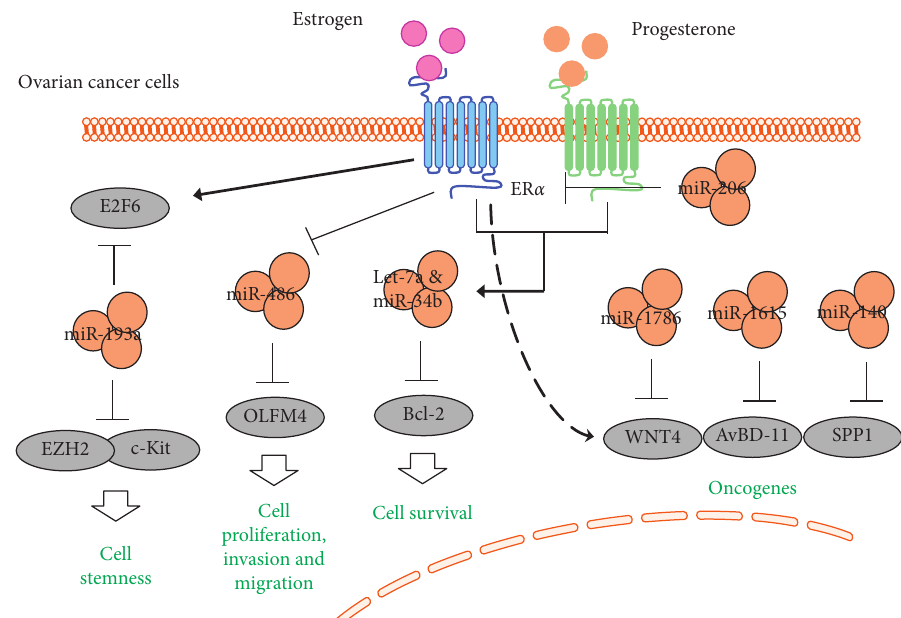
Figure 1: The interaction of miRNAs and estrogen in ovarian cancer. Several miRNAs have been reported that interact with estrogen and its receptor in ovarian cancer, including miR-193a, miR-486, let-7a, miR-34, and miR-206. Solid arrow: induction; flat-ended arrow: inhibition.